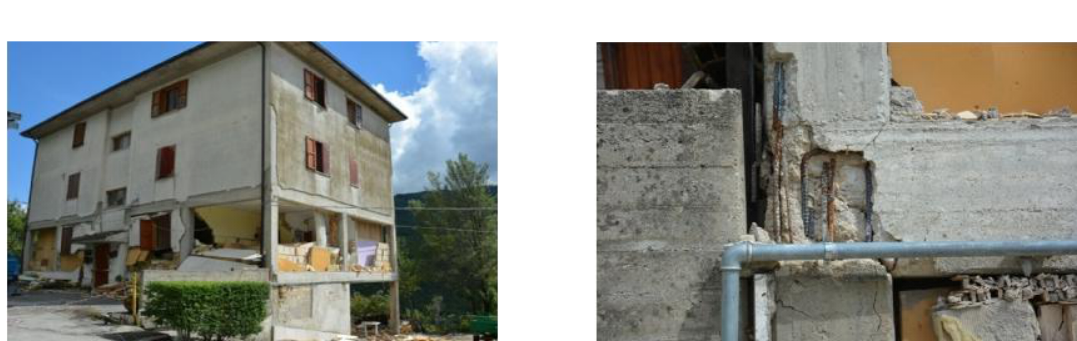
Figure 3: a) Reinforced concrete building in Pescara del Tronto, b) Detail of the damage to a beam-column joint.